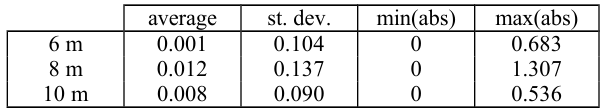
Table 1. Statistics on the differences between the percentages of OSM road length compliant with accuracy targets of 6 m, 8 m, and 10 m, in the cases of no generalization and generalization with threshold of 1